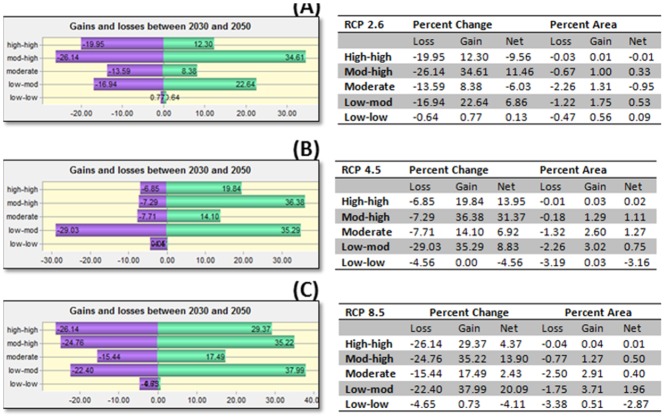
Change analysis into and out of 60% (0.6 probability) threshold category for Culicoides sonorensis occurrence probability as predicted with the Maximum Entropy algorithm under different climate change scenarios (Representative Concentration Pathways, RCP: RCP 2.6, RCP 4.5, RCP 8.5) projected for 2030–2050.Table represents both percent change and percent area of entire study area for loss, gain, and net change in pixels for each probability class category expressed as percentage (Low-low = 0–20%; low-mod = 21–40%; Moderate = 41–60%; Mod-high = 61–80%; and high-high = 81–100% probability of occurrence). Adjacent table visually indicates gains and losses (of percent change) for each class category. Percent change is defined by the number of pixels changed for a class divided by area of a class in later image, multiplied by one hundred. Percent area change is defined by the number of pixels changed for a class, divided by the total area of the land cover map, multiplied by one hundred.